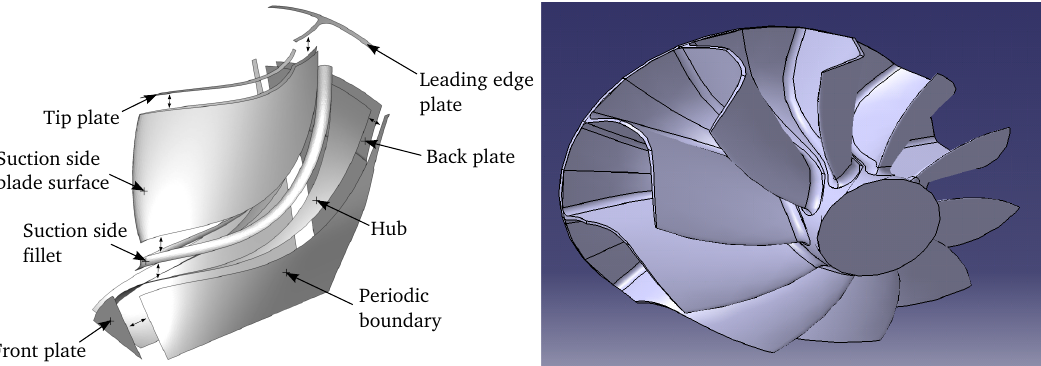
Figure 5. Exposed view of the boundary representation (BRep) of the solid turbine wheel model ( left ) and exported through the STEP file protocol to a computer-aided design (CAD) program ( right